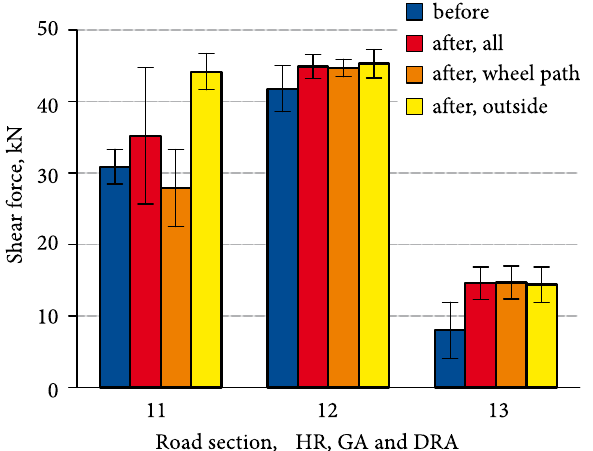
fig. 5. Comparison of shear stiffness at 20 °C directly after construction and after several years of traffic for all road sections with SMA surface